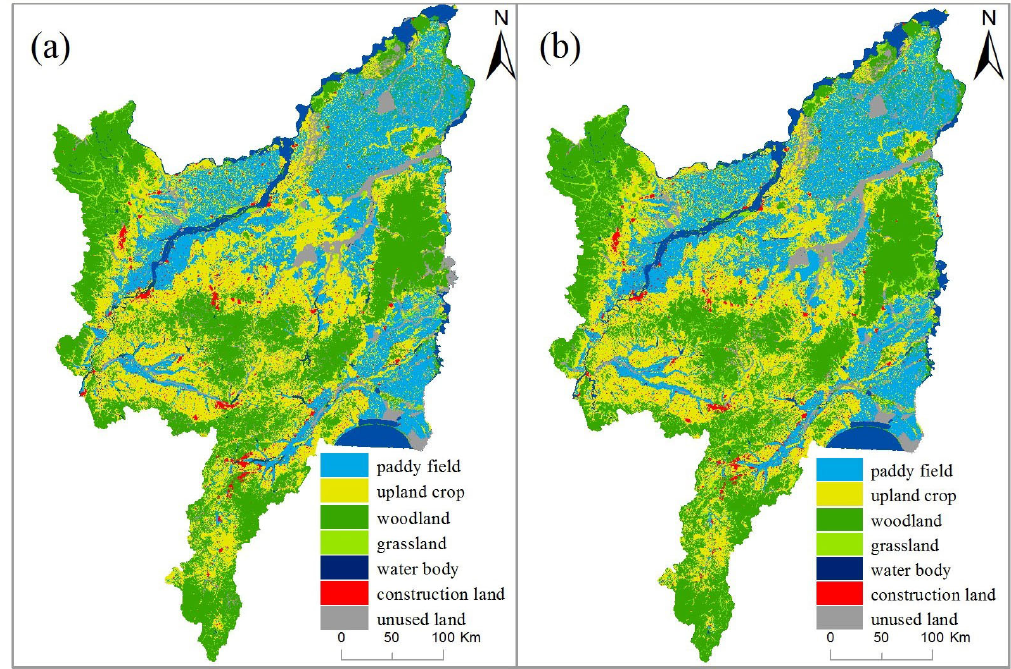
Figure 4. ( a ) Resulted map (comparison data) based on the prediction in 2015; and ( b ) Real map (reference data) based on the new dataset in 2015.